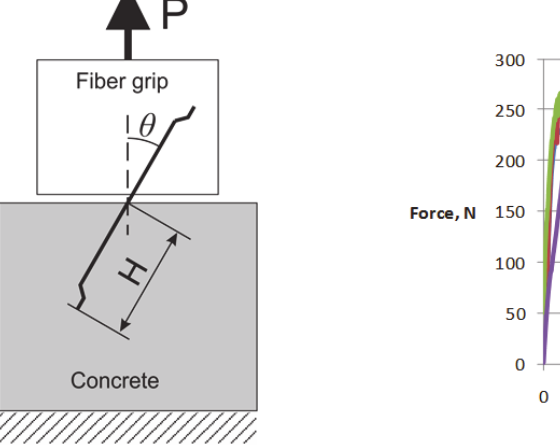
Figure 5: Experimental scheme and single fiber pull-out force at different angles.